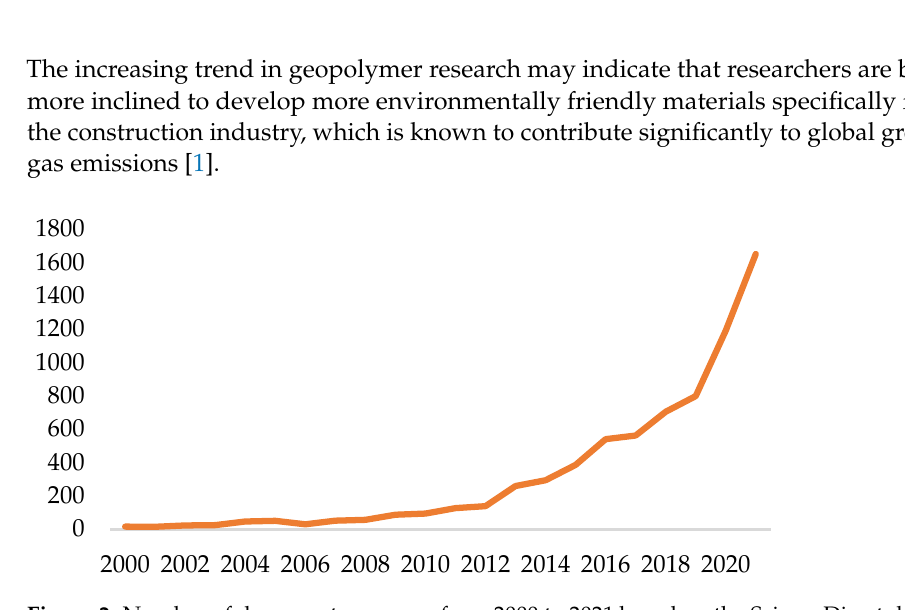
Figure 2. Number of documents per year from 2000 to 2021 based on the ScienceDirect database.